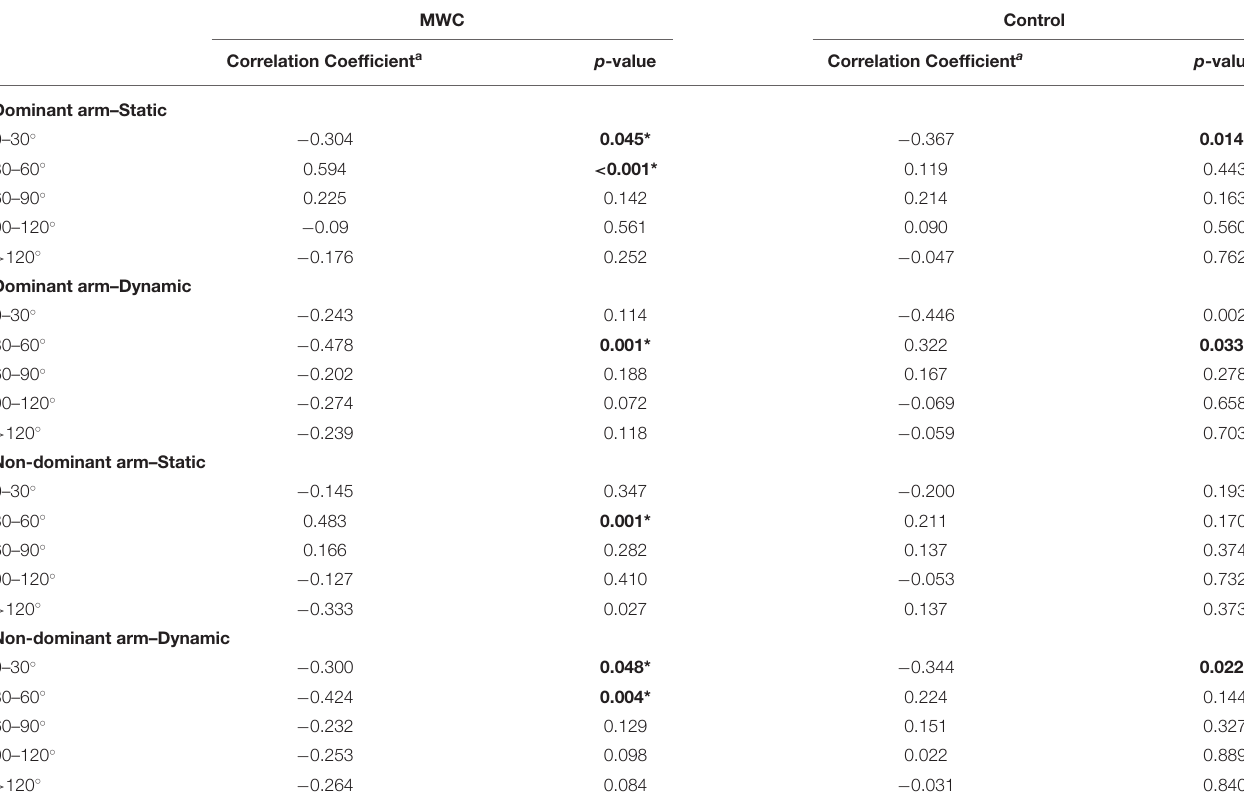
TABLE 3 | The correlation coefficient between age and the percentage of day spent static or dynamic in each humeral elevation